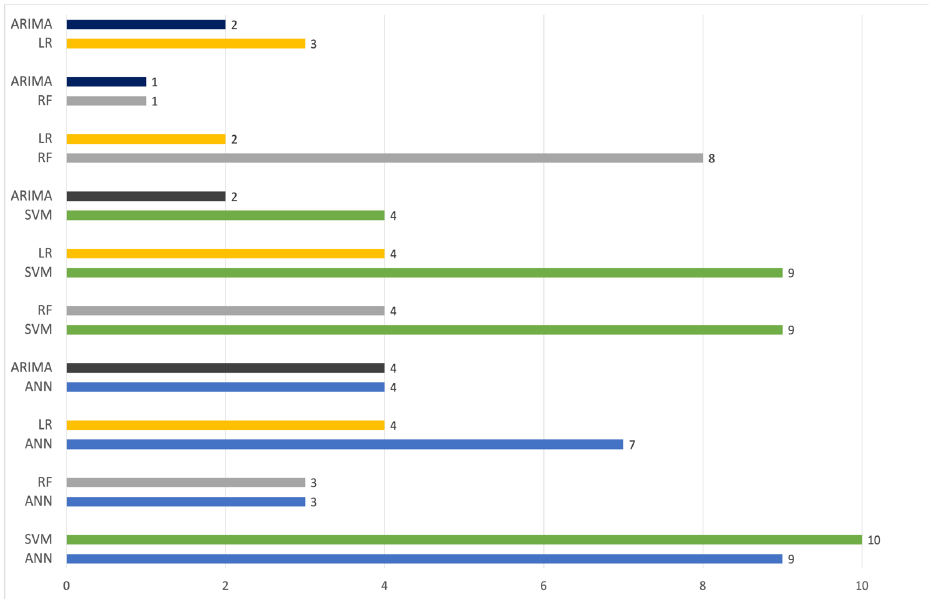
Figure 4. Pair-wise comparison based on the number of studies that noted one tool as being better than the